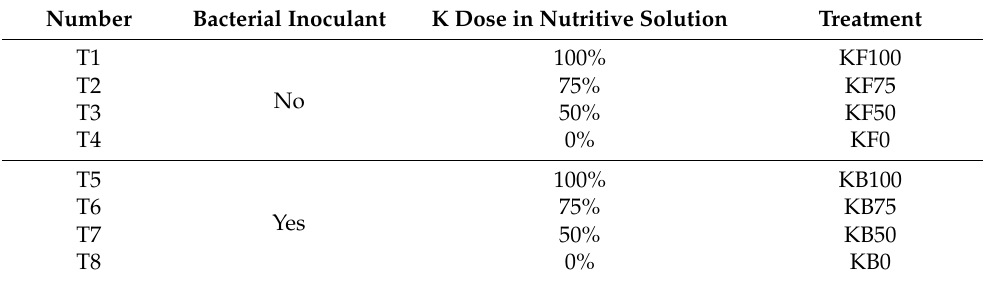
Table 7. Experimental treatments to evaluate the biofertilizing effect of Acinetobacter calcoaceticus